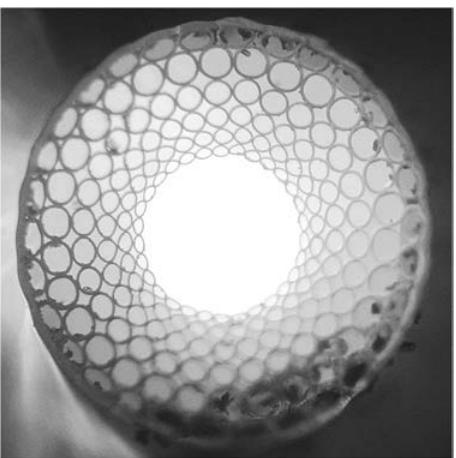
Fig. 1. The microphotograph of the cross-section of the hollow core